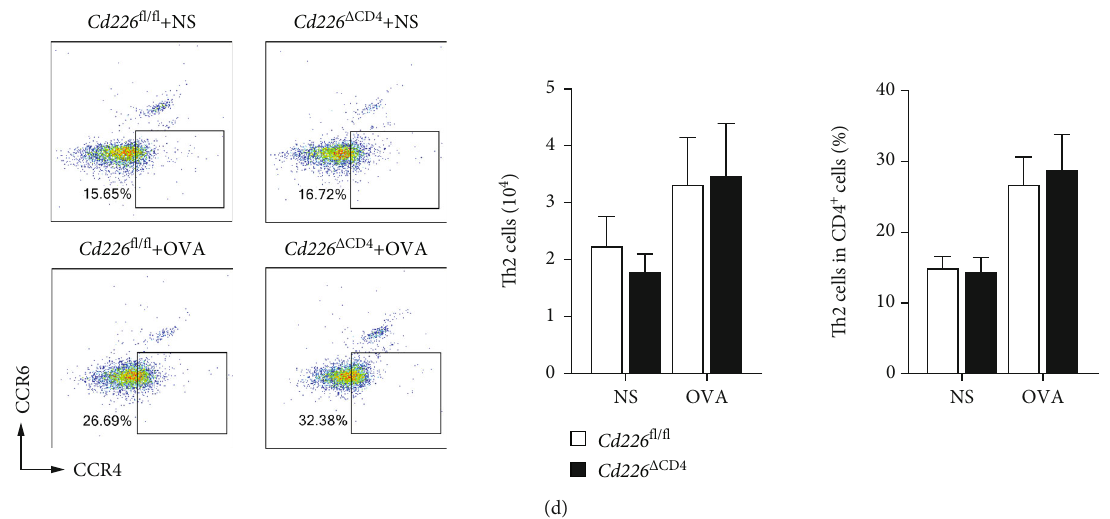
Figure 3: CD226 on CD4 + T cells plays a limited role in AR development. (a) Serum levels of IgE and OVA-speci fi c IgE detected using ELISA ( n = 8 ). (b, c) Representative images and quanti fi cation of HE stained nose and lung sections ( n = 9 ). (b) Scale bar = 50 μ m and (c) scalebar = 100 μ m. (d) Representative images, absolute number, and frequency of nasal Th2 cells (CD4 + CCR4 + CCR6 − ) were detected using FCM ( n = 3 ). AR: allergic rhinitis; OVA: ovalbumin; IgE: immunoglobulin E; ELISA: enzyme-linked immunosorbent assay, ∗ P < 0 : 05 , ∗∗ P < 0 : 01 , and ∗∗∗ P < 0 : 001